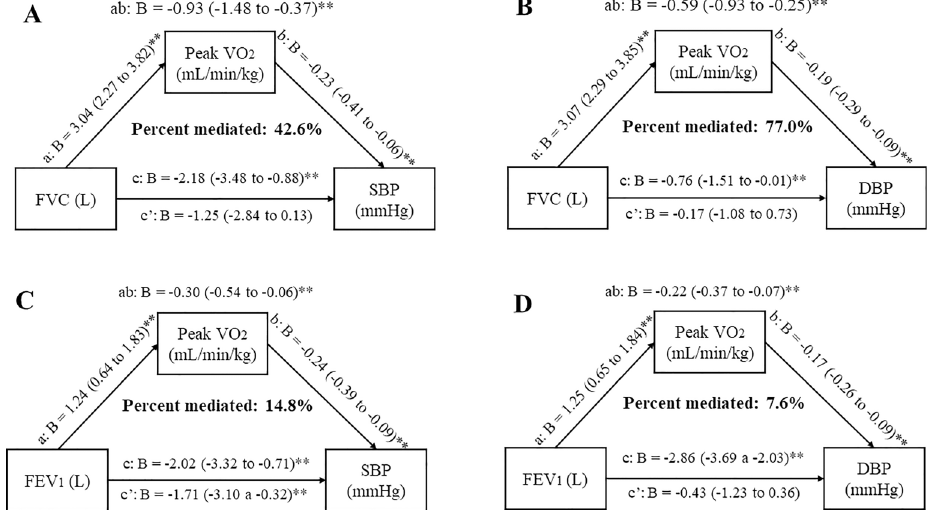
. VO 2 ) during a treadmill